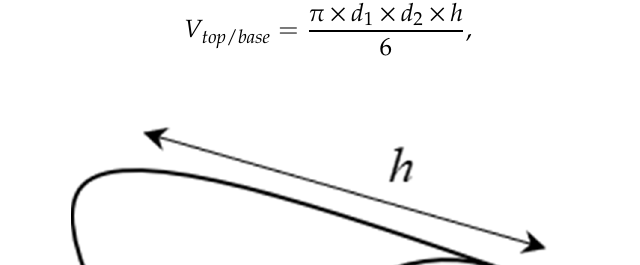
Figure 5. Cross-section of an elliptical vegetable or fruit.